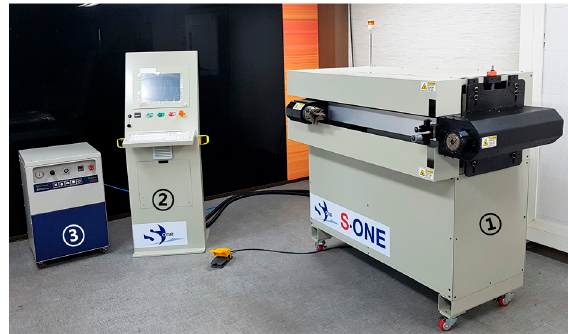
Figure 6. Establishment of CNC bending machine. In the figure, components of the CNC bending machine are (1) main body, (2) control cabinet, and (3) air pump.